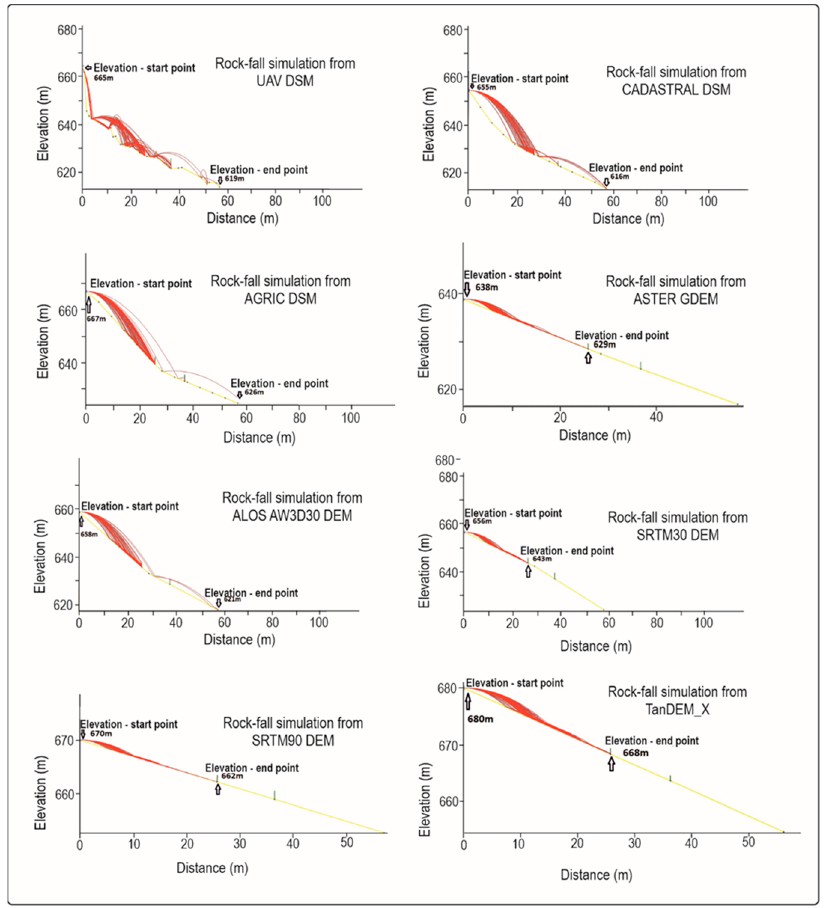
Figure 15. Two-dimensional rockfall simulations via RocFall software for the 2nd slope profile.